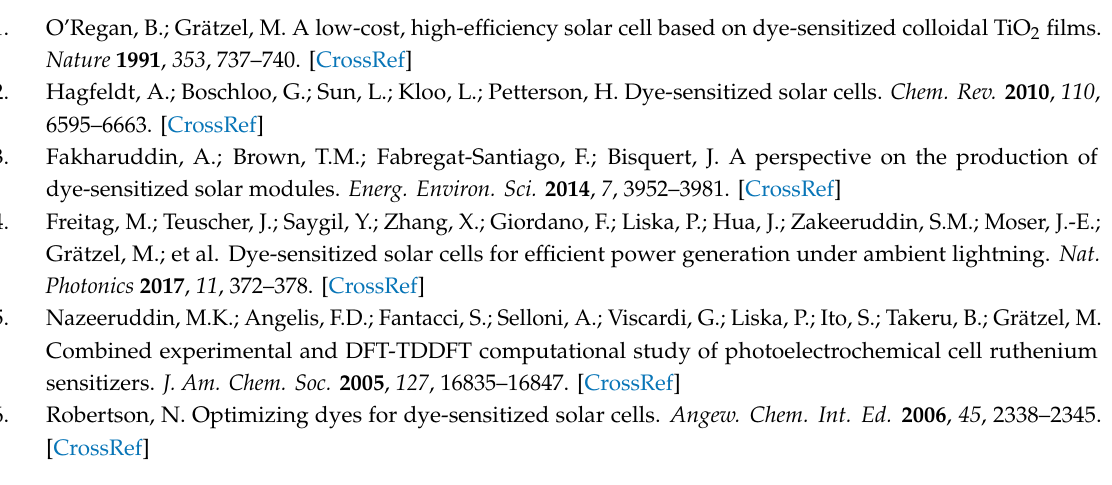
Figure S1: (a) FTIR, (b) 1 H NMR, (c) 13 C NMR, and (d) HSQC spectra of CSD-03, Figure S2: (a) FTIR, (b) 1 H NMR, (c) 13 C NMR, and (d) HSQC spectra of